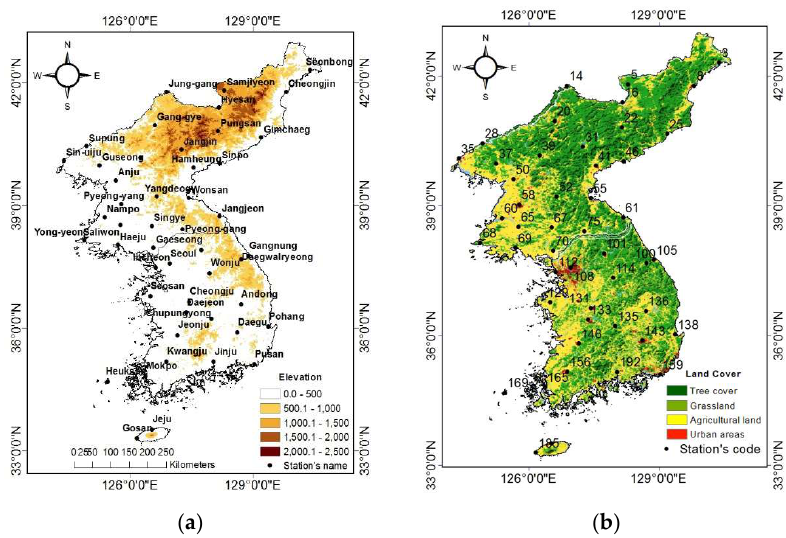
Figure 1. Spatial distribution of ( a ) topographic characteristics and name of weather stations, and ( b ) land cover and code of stations on the Korean Peninsula.